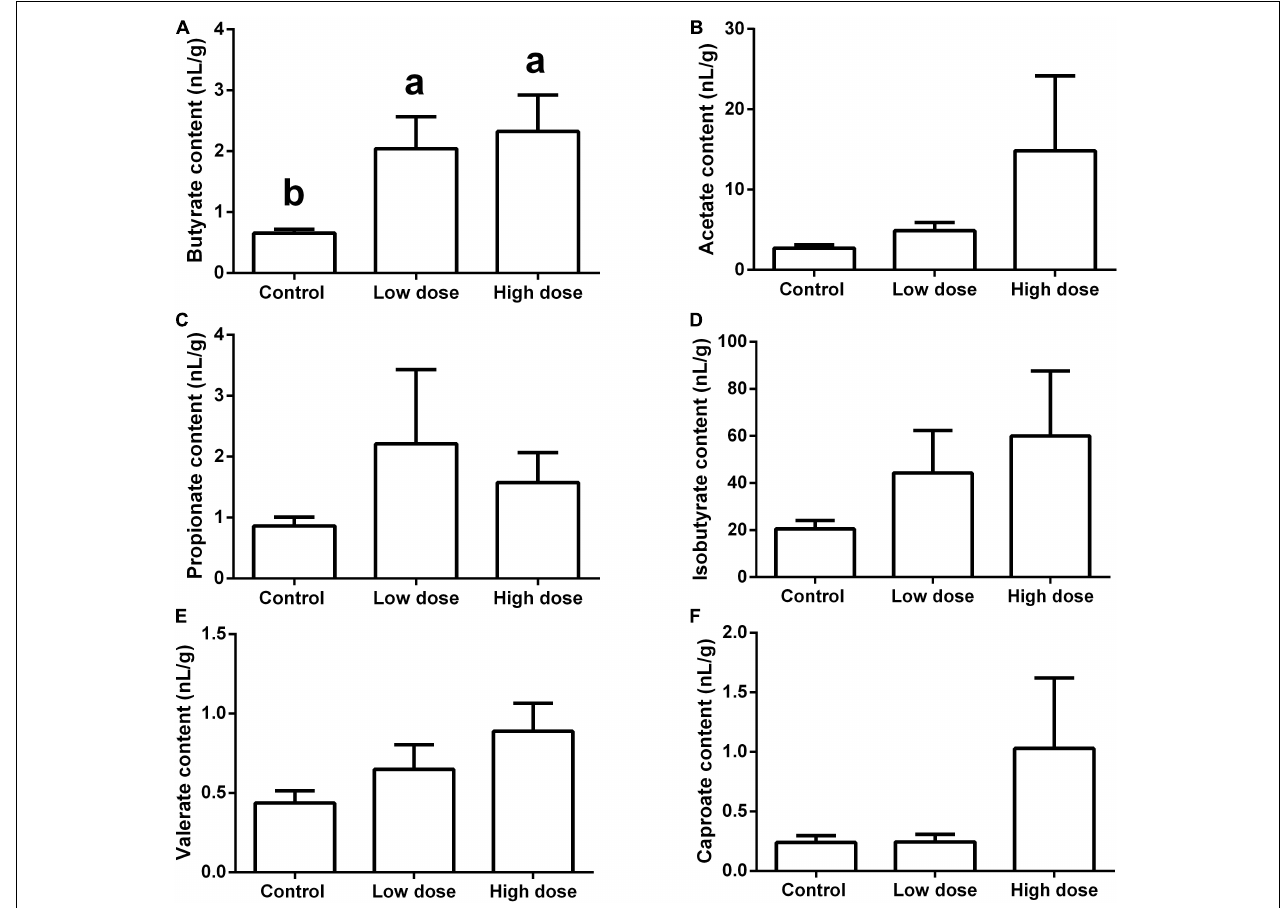
FIGURE 7 | Short-chain fatty acids (SCFAs) content in the cecum of adult male Brandt’s vole intragastrically administered a 6-MBOA dose of 0 mg/kg (control group), 1 mg/kg (low dose group), or 2 mg/kg (high dose group). (A) Butyrate; (B) acetate; (C) propionate; (D) isobutyrate; (E) valerate; (F) caproate. Error bars indicate standard errors. Same letters connect bars with no significant differences at P < 0.05 ( n =